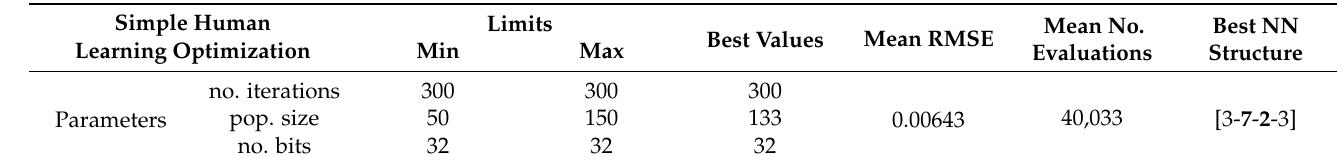
Table A3. The best results provided by the search procedure for the Simple Human Learning Optimization algorithm.